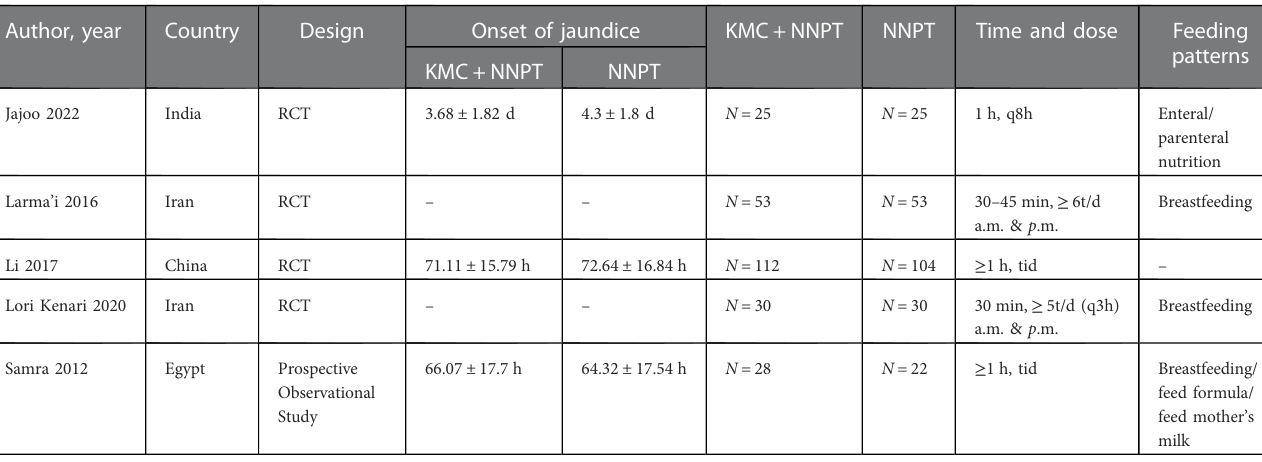
TABLE 1 Characteristics of included studies in the meta-analysis.